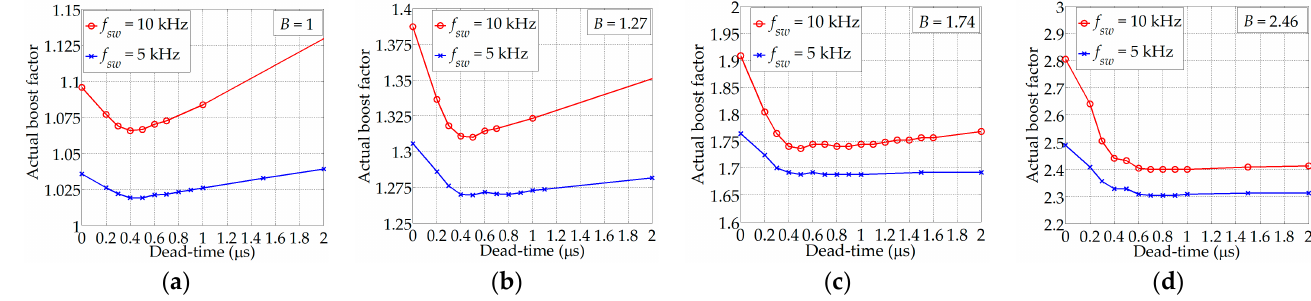
Figure 15. Actual boost factor as a function of the dead-time for applied B = 1 ( a ), B = 1.27 ( b ), B = 1.74 ( c ), and B = 2.46 ( d ).